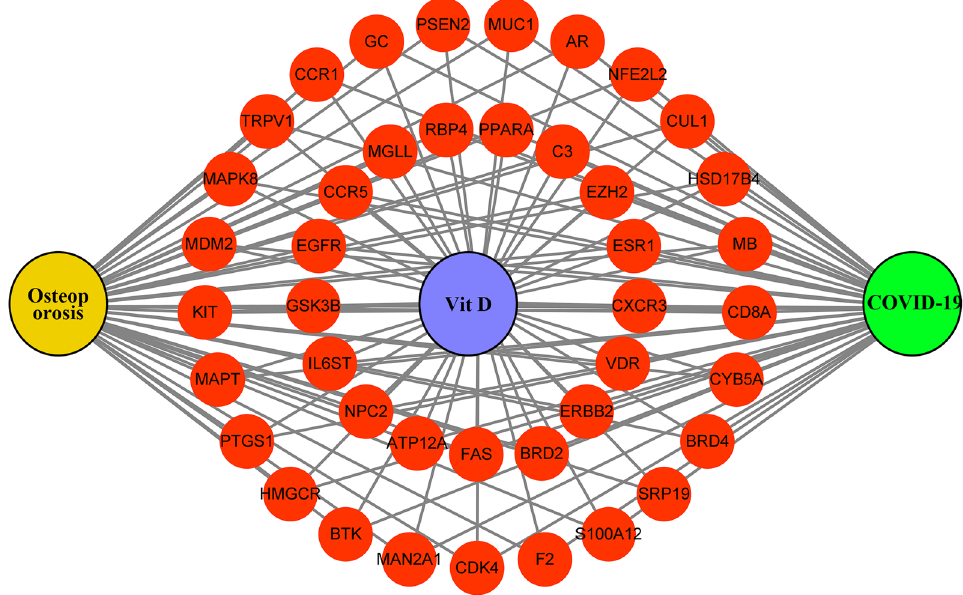
Figure 3. Drug-Targets-Disease Interaction Network. Graphs were constructed to link VitD to osteoporosis and COVID-19 targets. VitD can act on osteoporosis and COVID-19 through the 42 targets shown.